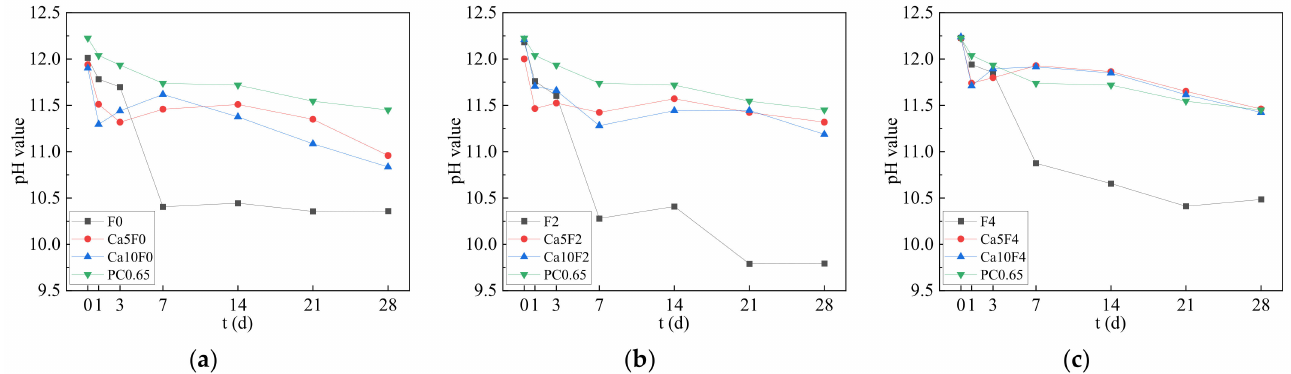
Figure 5. The changes in material alkalinity of geopolymer and cement with carbonation age. ( a ) F0; ( b ) F2; ( c )